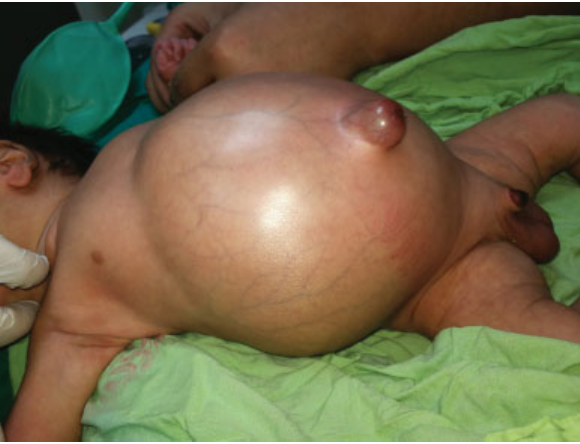
Fig. 1 Clinical picture of the baby at fi rst presentation. Notice the gross distended abdomen, dilated abdominal veins, mild erythema of the abdominal wall and dry gangrene of the distal glans of the penis.